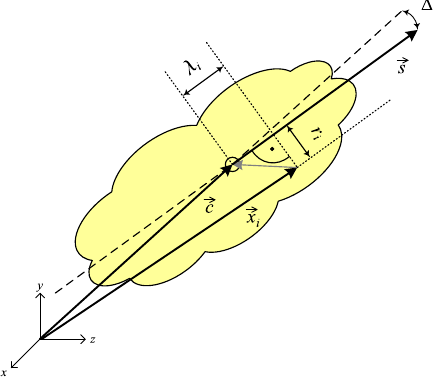
Fig. 8 Schematic view of geometrical moments for topo-clusters respect to its origin, and therefore cluster-based